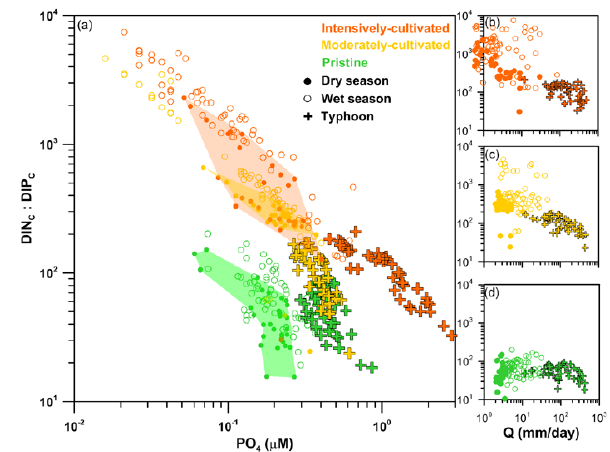
Fig. 7. (a) The distribution of observed DIN C :DIP C ratio against phosphate concentrations under different hydrologic controls and cultivation levels. The relationship between the DIN C :DIP C ra- tio versus discharge for the (b) pristine (in green), (c) moderately cultivated (in yellow), and (d) intensively cultivated watersheds (in orange). The solid circle, hollow circle, and cross symbol rep- resent the DIN C : DIP C sampled in dry season, wet season, and typhoon period, respectively. Except outliers, dry-season samples were grouped together in colored areas. Only data collected in 2007 were